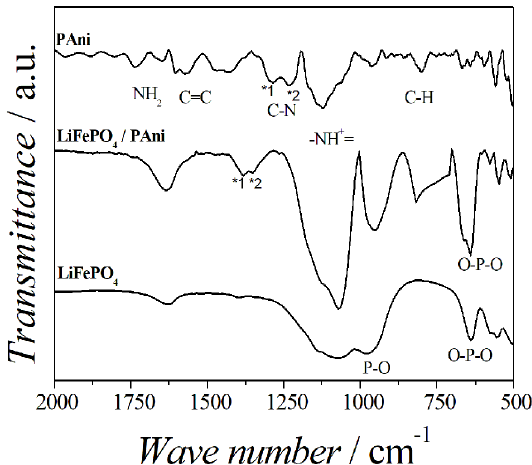
, PAni and LiFePO 4